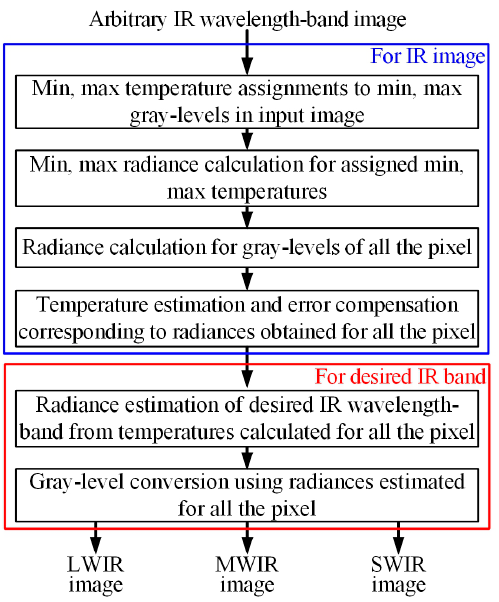
Figure 3. Flow chart of proposed wavelength-band conversion method.